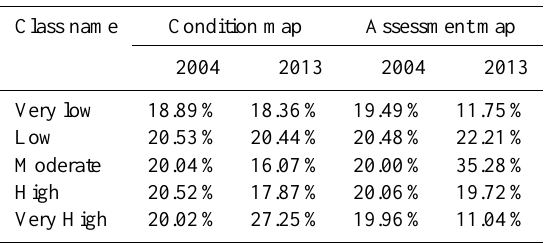
Table 2. The areal percentage of each class for the condition and assessment